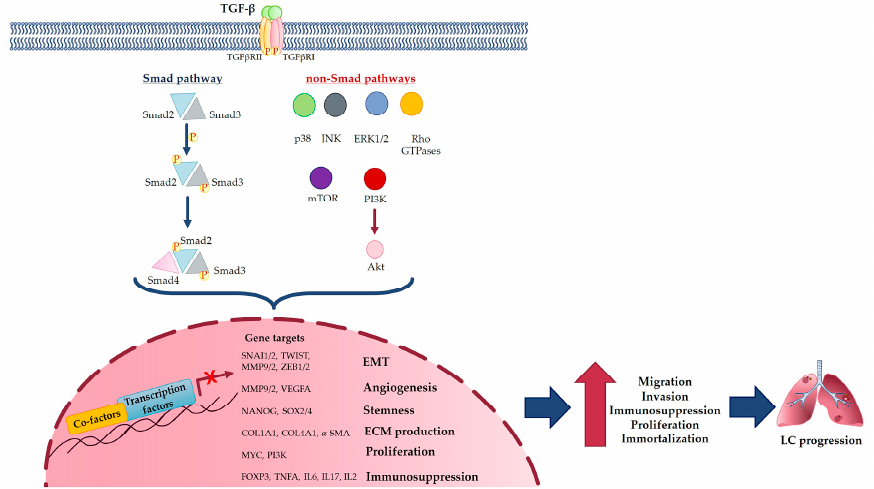
Figure 2. TGF- β signaling pathway in LC development and